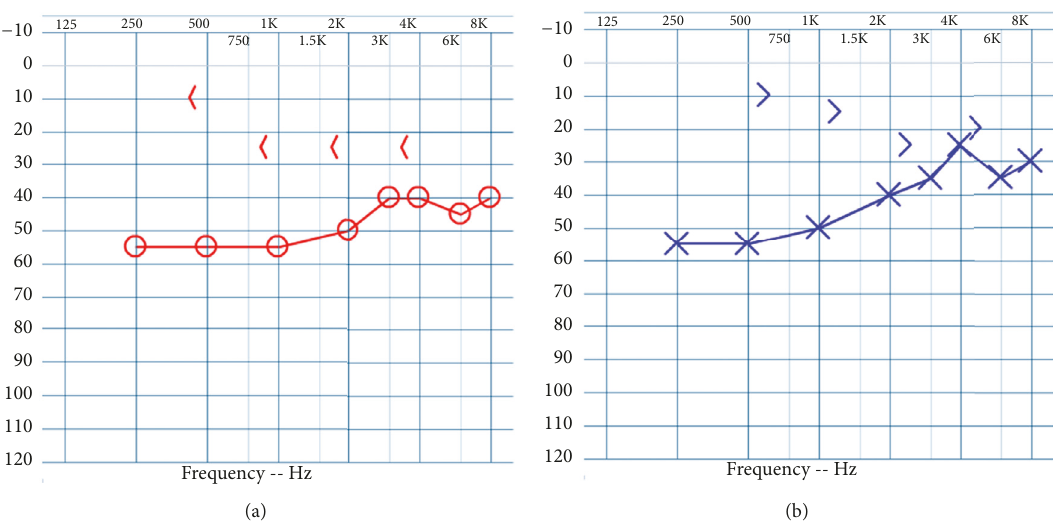
Figure 1: Preoperative pure tone audiometry revealed bilateral moderate rising to mild conductive hearing loss on the right (a) and left (b). Ipsilateral and contralateral stapedial reflexes were absent